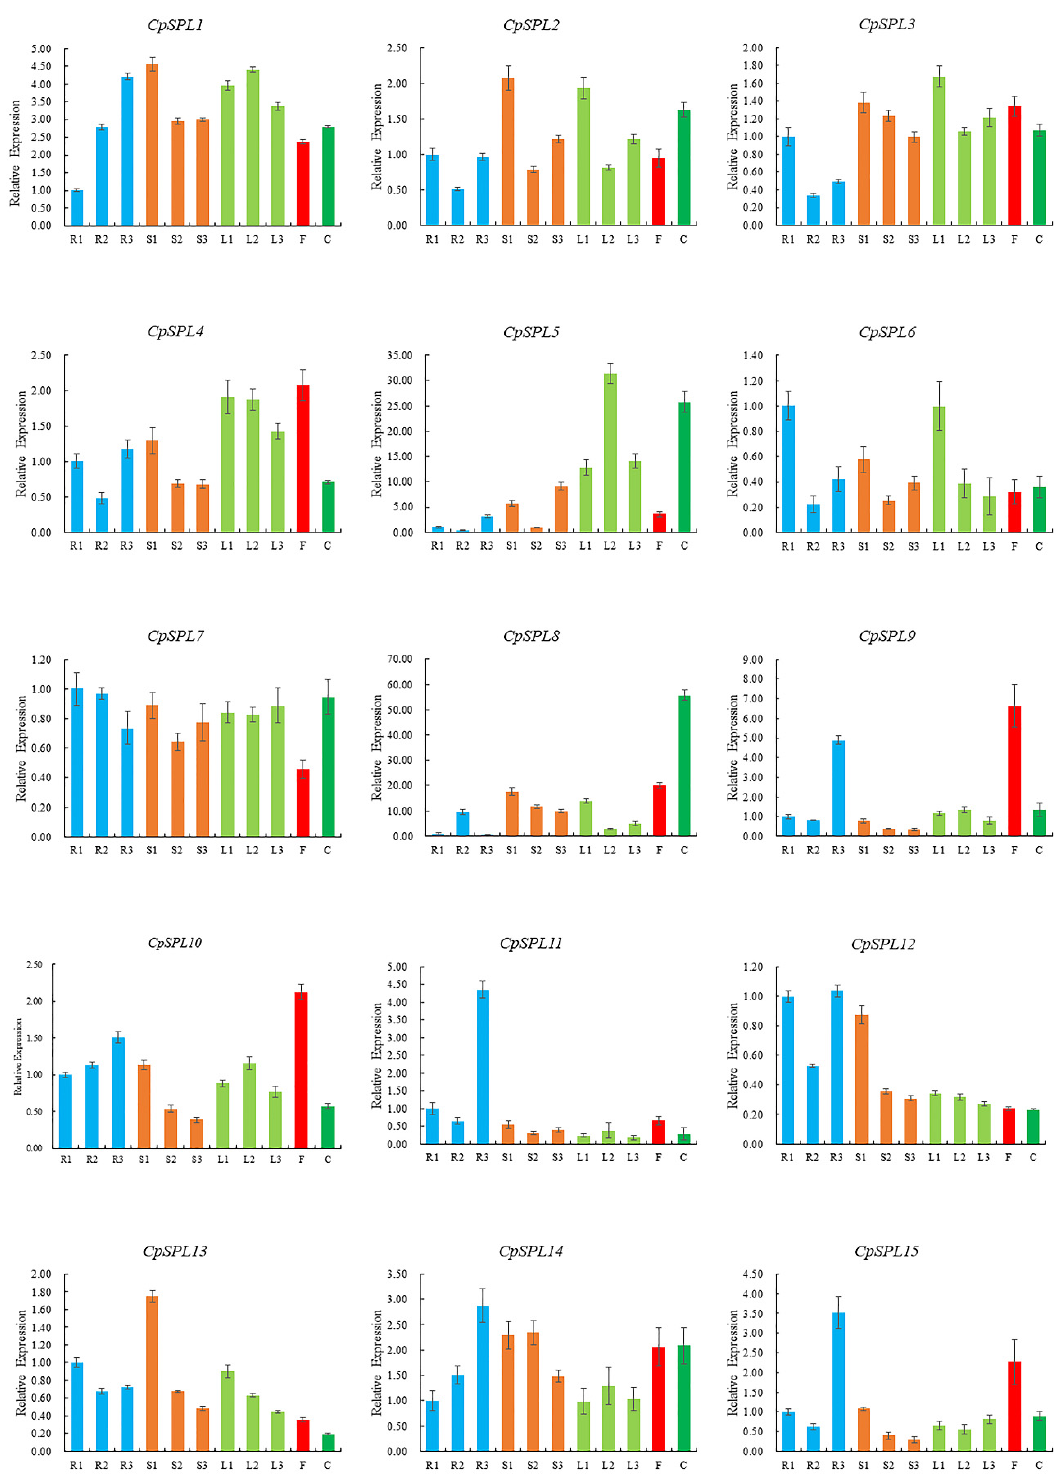
Figure 4. Spatiotemporal expression analysis of 15 SPL genes in Codonopsis pilosula . R1, R2 and R3 represent roots from one-month-old seedlings, two-month-old seedlings and three-month-old plantlets, respectively; S1, S2 and S3 represent stems from one-month-old seedlings, two-month-old seedlings and three-month-old plantlets, respectively; L1, L2 and L3 represent leaves from one-month-old seedlings, two-month-old seedlings and three-month-old plantlets, respectively; F: flower; C: calyx.